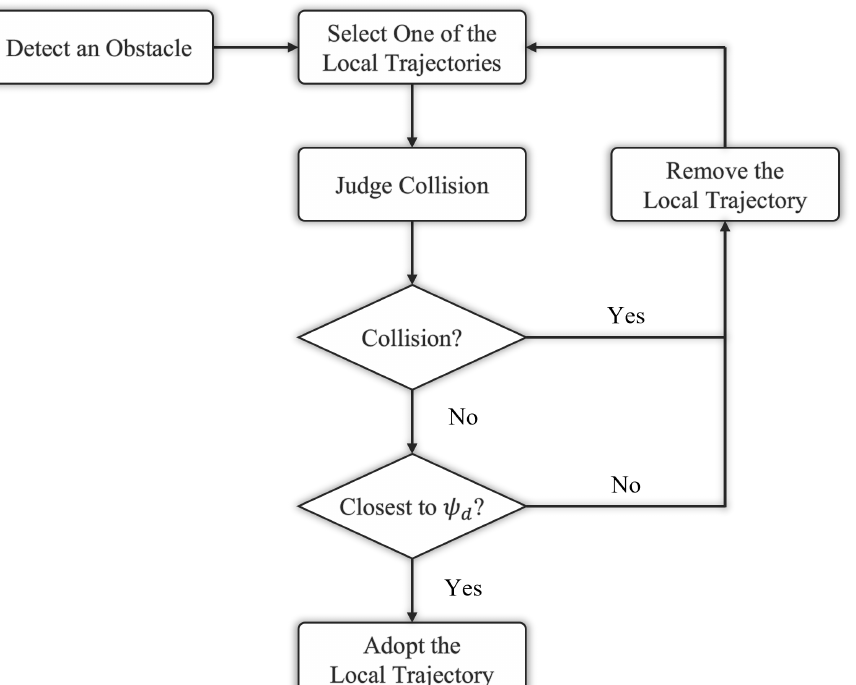
Figure 5. Procedure of collision avoidance check and motion primitive